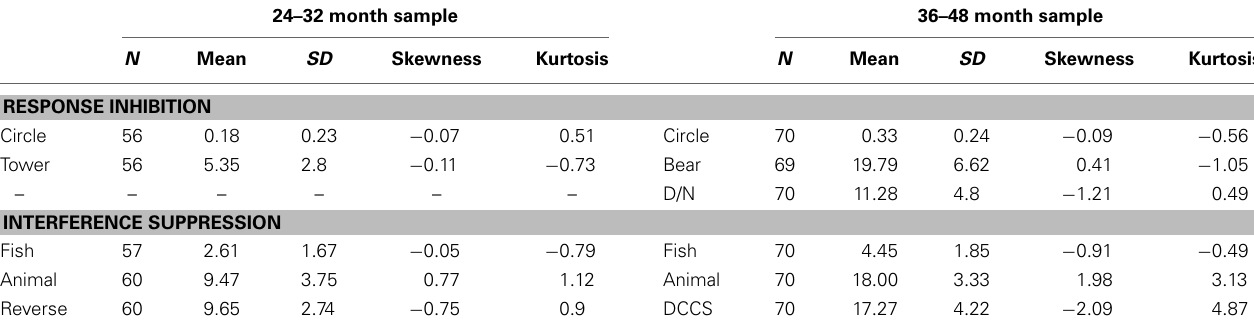
Table 1 | Descriptive statistics for the inhibitory measures used in 24–32 month sample and in 36–48 month